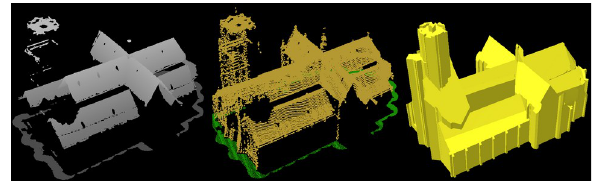
Figure 4 . Missing points (no-data) in the point cloud. The church tower occluded part of the roof from the laser beams. The impact on the reconstruction can be seen in the yellow